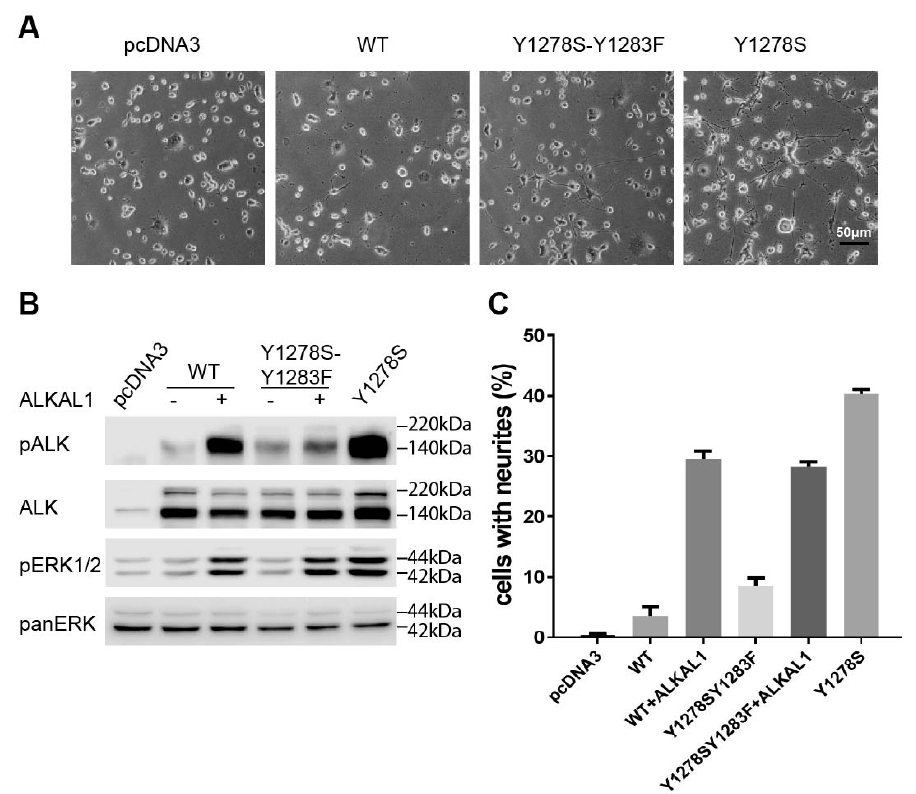
Figure 5. Characterization of the importance of Y1283 for ALK-Y1278S activity. ( A ) Representative images of PC12 cells expressing pcDNA3 empty vector, wild type ALK, ALK-Y1278S, Y1283F or ALK-Y1278S mutants respectively. Scale bar represents 50 µ m; ( B ) Detection of phosphorylation of ALK (Y1604) and downstream signalling activity (pERK1/2) of wild type ALK, ALK-Y1278S, Y1283F and ALK-Y1278S in the absence or presence of ALKAL1 ligand by immunoblotting. Blots are representative of three independent experiments; ( C ) Neurite outgrowth assay of PC12 cells transfected with various ALK mutants as indicated in the presence or absence of ALKAL1 stimulation. Bars represent mean percentage ± STD of neurite-carrying cells among GFP-positive cells from three independent experiments.